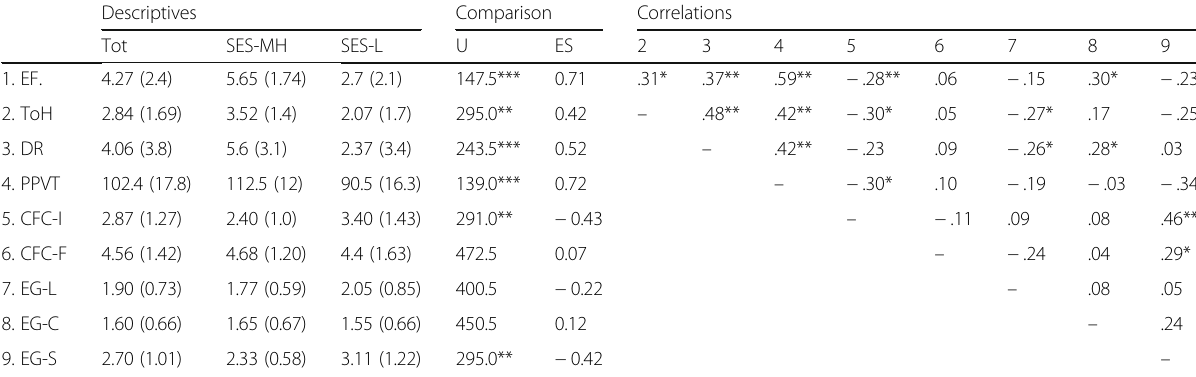
Table 2 Descriptive statistics, group comparison results by SES, and Spearman ’ s correlations between measures Descriptives Comparison Correlations